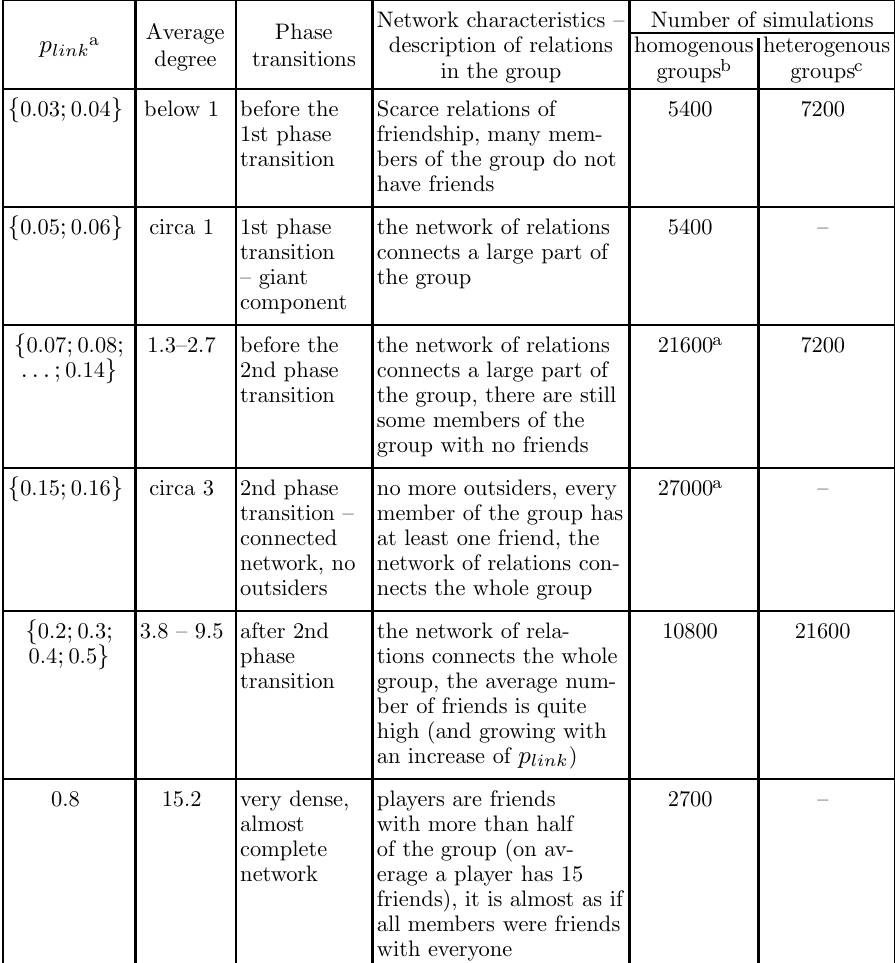
Expected (average) number of player’s friends depending on the value of p link Network characteristics – Number of simulations Average Phase p link a description of relations homogenous heterogenous